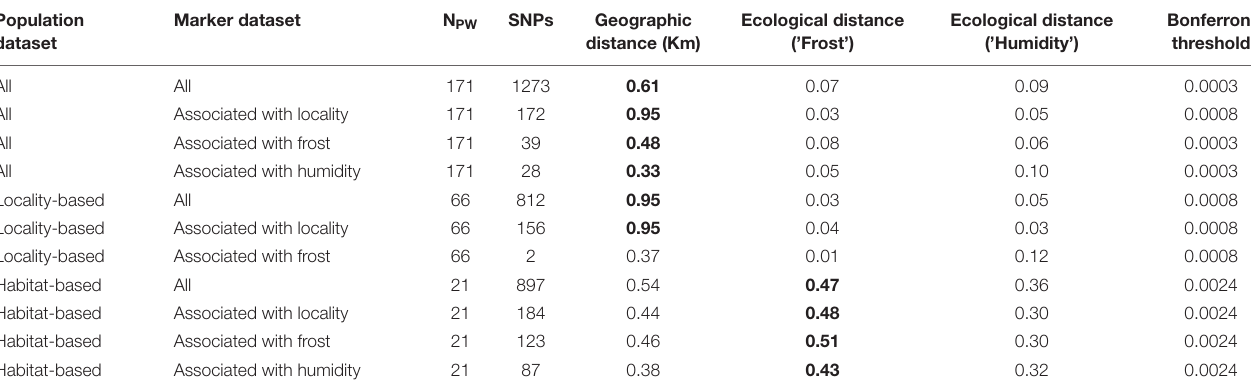
TABLE 1 | Correlations between genetic differentiation, geographic distance, and ecological distance (exposure to frost and soil moisture content) among populations of Espeletia growing in 3 different habitats and 6 localities. Population Marker dataset N PW SNPs Geographic dataset